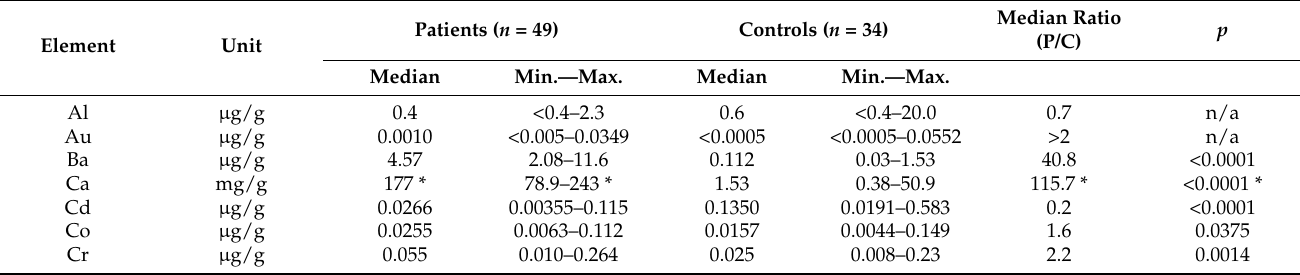
Table 2. Concentrations of metals and trace elements in the tissue of aortic valves of patients and